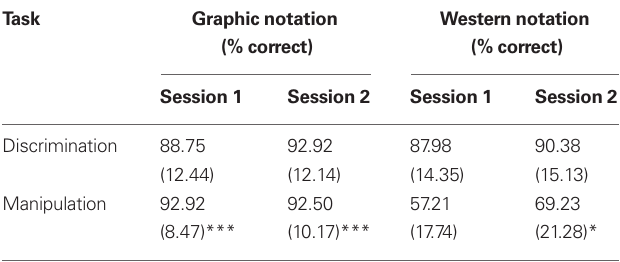
Table 5 | experiment 1 audio-visual (AV) discrimination and manipulation performance ( ±